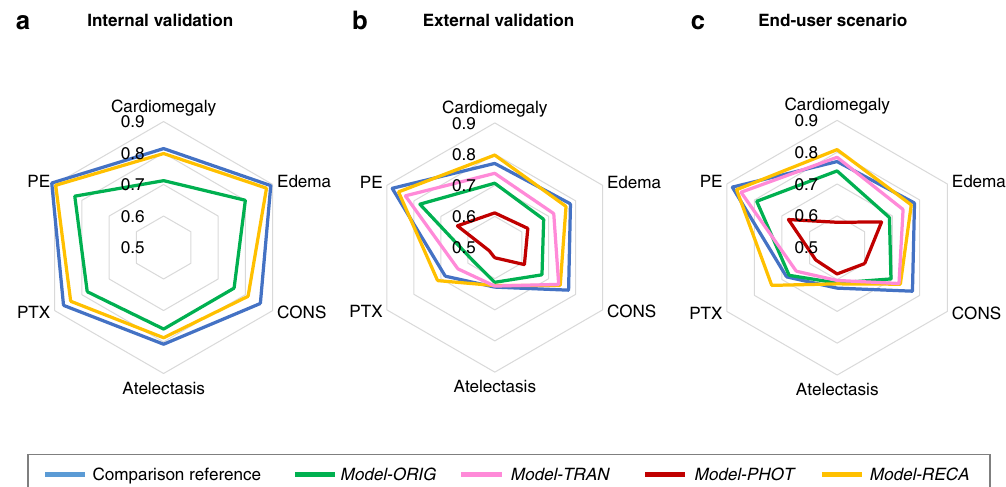
Fig. 2 Radiographic detection performance evaluated by AUROCs for six labels including cardiomegaly, edema, consolidation, atelectasis, pneumothorax, and pleural effusion, using different approaches. a Internal validation: the comparison for the models tested on MIMIC CXRs and the photographic copies ( Photo-MMC ). b External validation: the comparison for the models tested on CheXpert CXRs and the photographic copies ( Photo-CXP ). c End-user scenario: the comparison for the models tested on photographs taken by medical residents ( Photo-MED ). In these fi gures, blue lines show the comparison reference performance of the models tested on original CXRs. Among the three experiments, except for the baseline model, the proposed model, Model-RECA, outperformed the other models. (PTX: Pneumothorax; PE: Pleural effusion; Cons.: Consolidation; Model-ORIG : Model trained on MIMIC-CXR; Model-RECA : Recalibrated model trained on MIMIC-CXR; Model-TRNS : Model transferred from Model-ORIG and fi ne-tuned by MIMIC-CXR photographs; Model-PHOT : Model trained on MIMIC-CXR